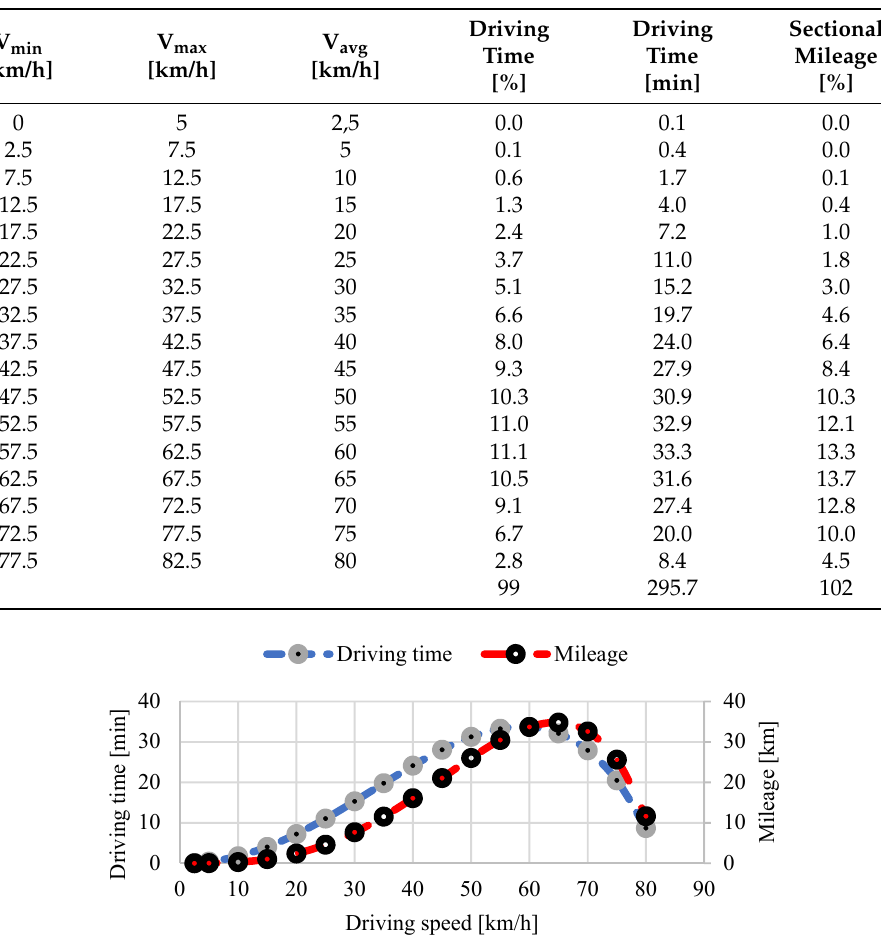
Table 2. Data for Beta speed distribution (example) [27].